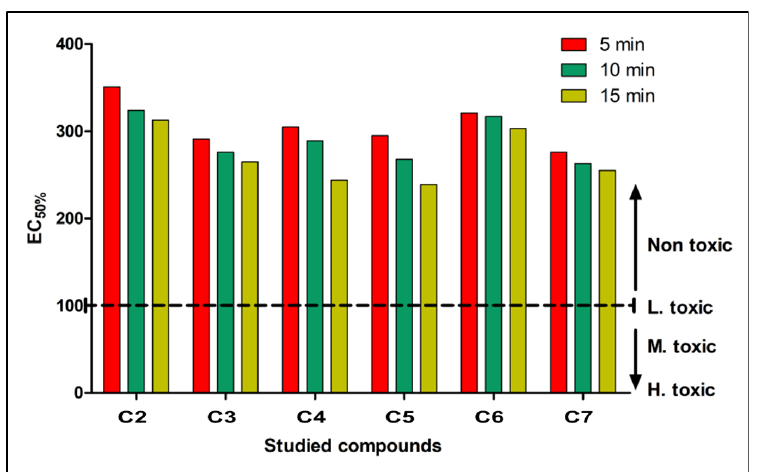
Figure 2. Estimated EC 50% level at three different time intervals of all studied